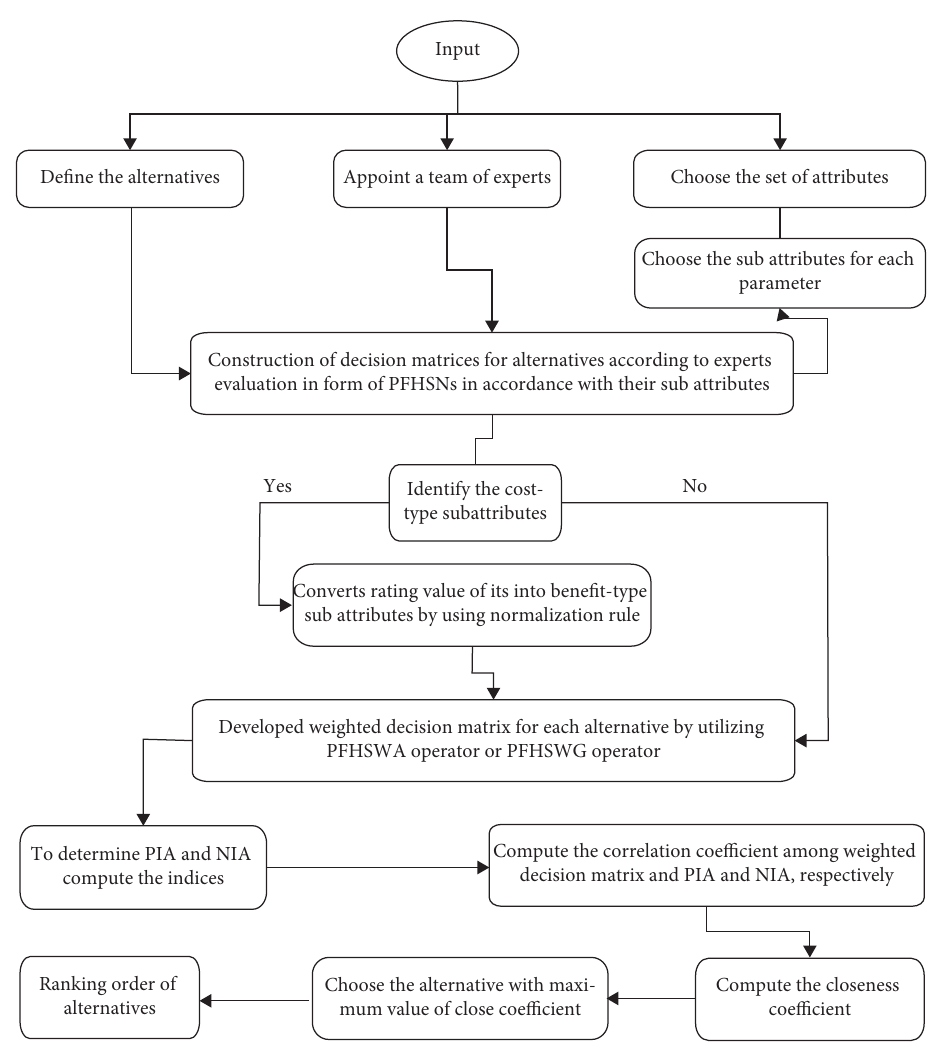
Figure 1: Flow chart of TOPSIS method under PFHSS